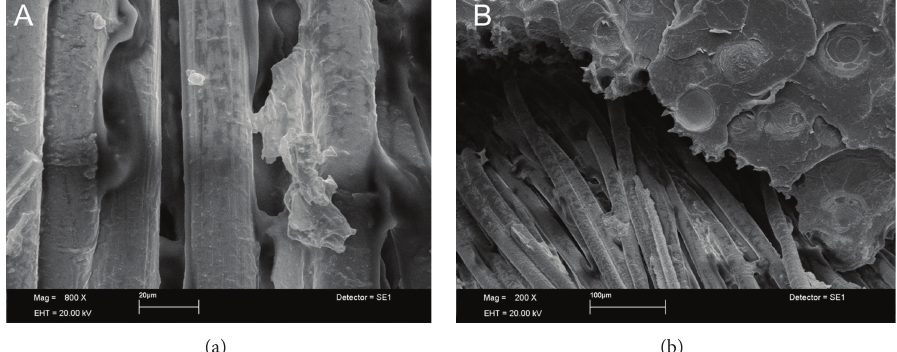
Figure 4: (a) Thermoplastic fiber showing presence of wax around fibers ( × 800 magnification). Interaction with resin was jeopardized. (b) Complete dislodgement between thermoplastic resin fibers and acrylic due to presence of wax around fibers ( × 200